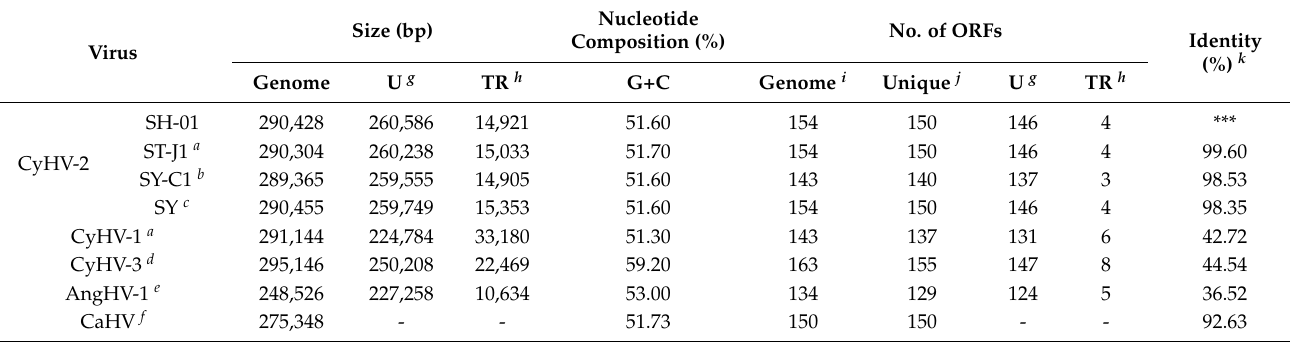
Table 1. Genome features of CyHVs, AngHV-1, and